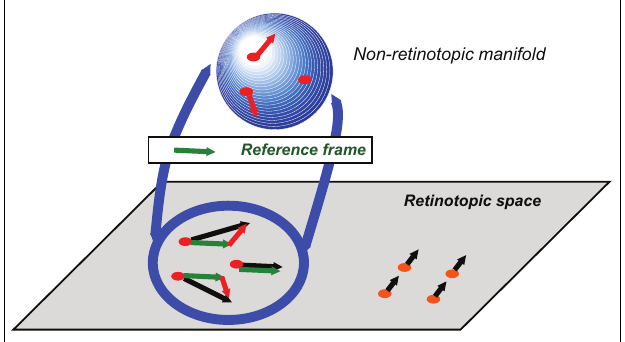
FIGURE 8 | Schematic depiction of the proposed approach to conceptualize non-retinotopic representations wherein feature processing, binding, and integration take place. The two-dimensional plane at the bottom of the figure depicts the retinotopic space in early vision. In this example, a group of dots (shown in red) moves rightward and a second group of dots (shown in orange) moves upward. A fast motion segregation and grouping operation establishes two distinct local neighborhoods, which are mapped into two different non-retinotopic representations (for clarity, the figure shows only the non-retinotopic representation for rightward moving dots). A vector decomposition takes place (e.g., Johansson, 1973) and a common vector for the neighborhood (dashed green vector) serves as the reference frame for the neighborhood. The stimulus in the local neighborhood is mapped on a non-retinotopic manifold (for depiction purposes a sphere is used).This allows the processing and integration of features in a manner that remains invariant to their global motion. Features that are mapped to common manifolds become candidates for binding into groups (from Ögmen and Herzog,